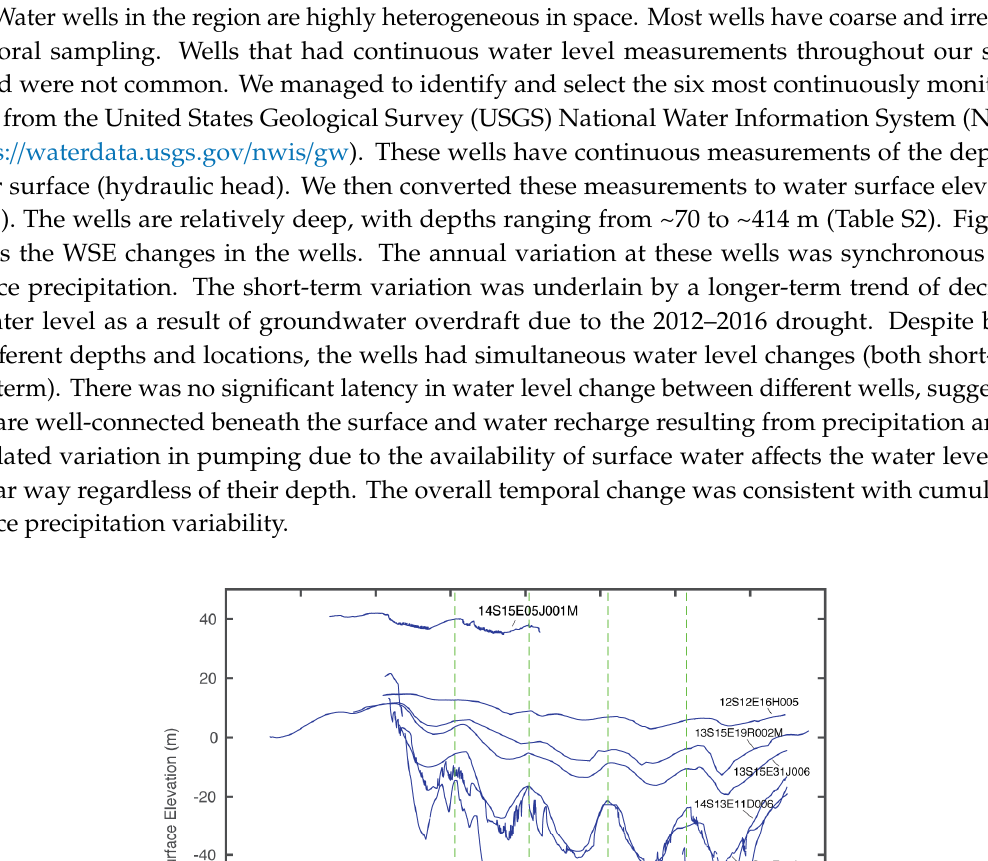
Figure 6. Precipitation records derived from Parameter‐Elevation Regressions on Independent Slopes Model (PRISM) for the San Joaquin Valley (SJ) basin and Tulare (TU) basin and a combination of the two, showing seasonal variations. There is much higher precipitation in 2017 due to the second wettest rainy season on record.